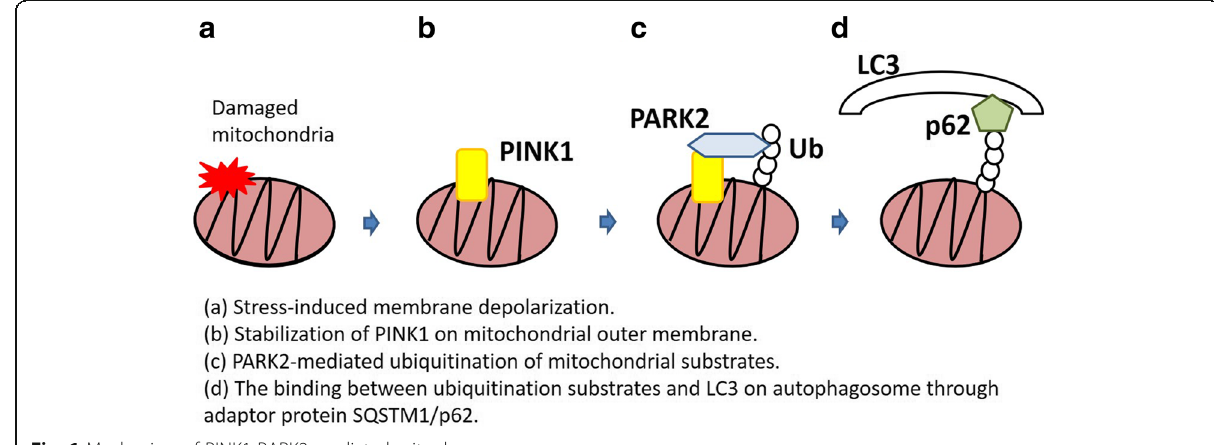
Fig. 1 Mechanism of PINK1-PARK2-mediated